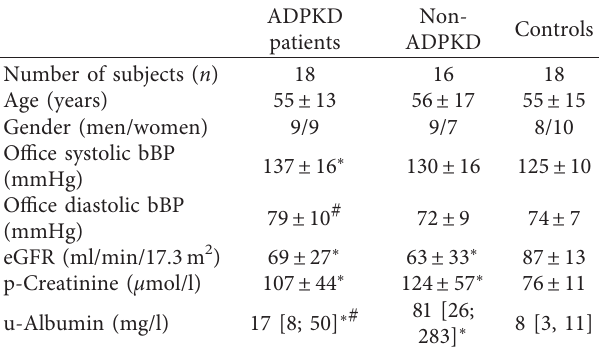
Table 1: Baseline demographics of the participants in the